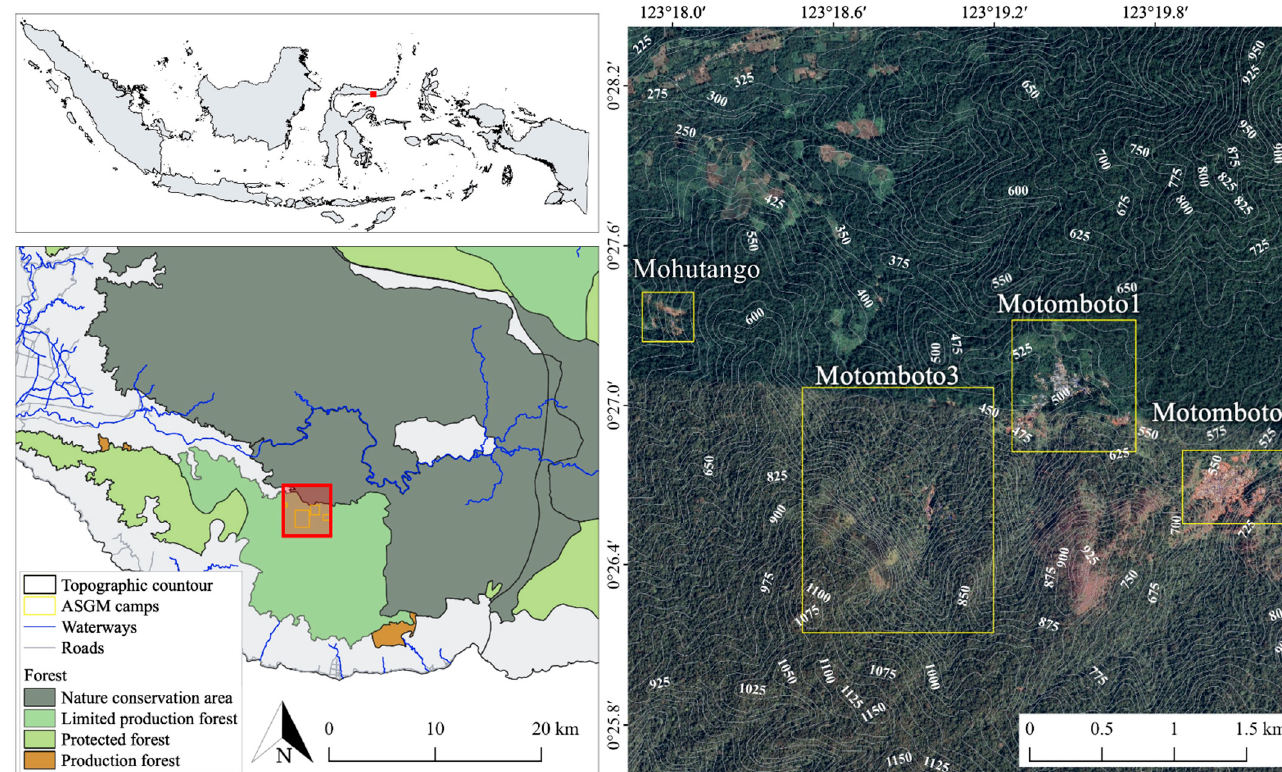
Figure 2. Study area.